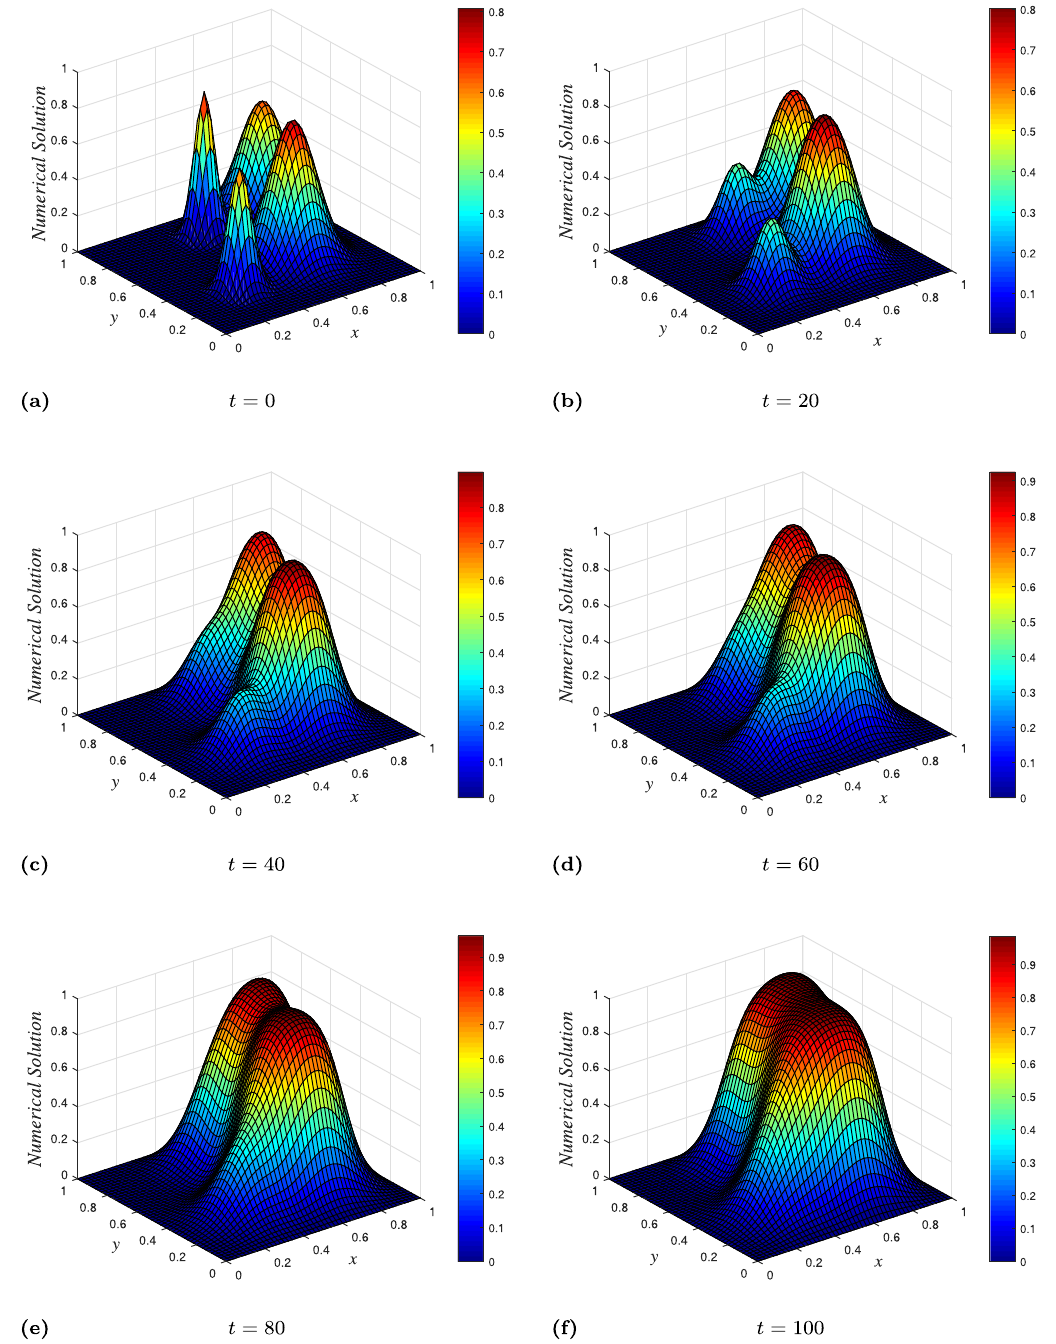
Figure 4: Plot of numerical solution vs x vs y using NSFD scheme at times = t 0, 20, 40, 60, 80 , and 100 with used spatial step sizes = = h h 0.02 x y and time - step = k 0.55 . ( a ) = t 0 . ( b ) = t 20 . ( c ) = t 40 . ( d ) = t 60 . ( e ) = t 80 . ( f ) = t 100